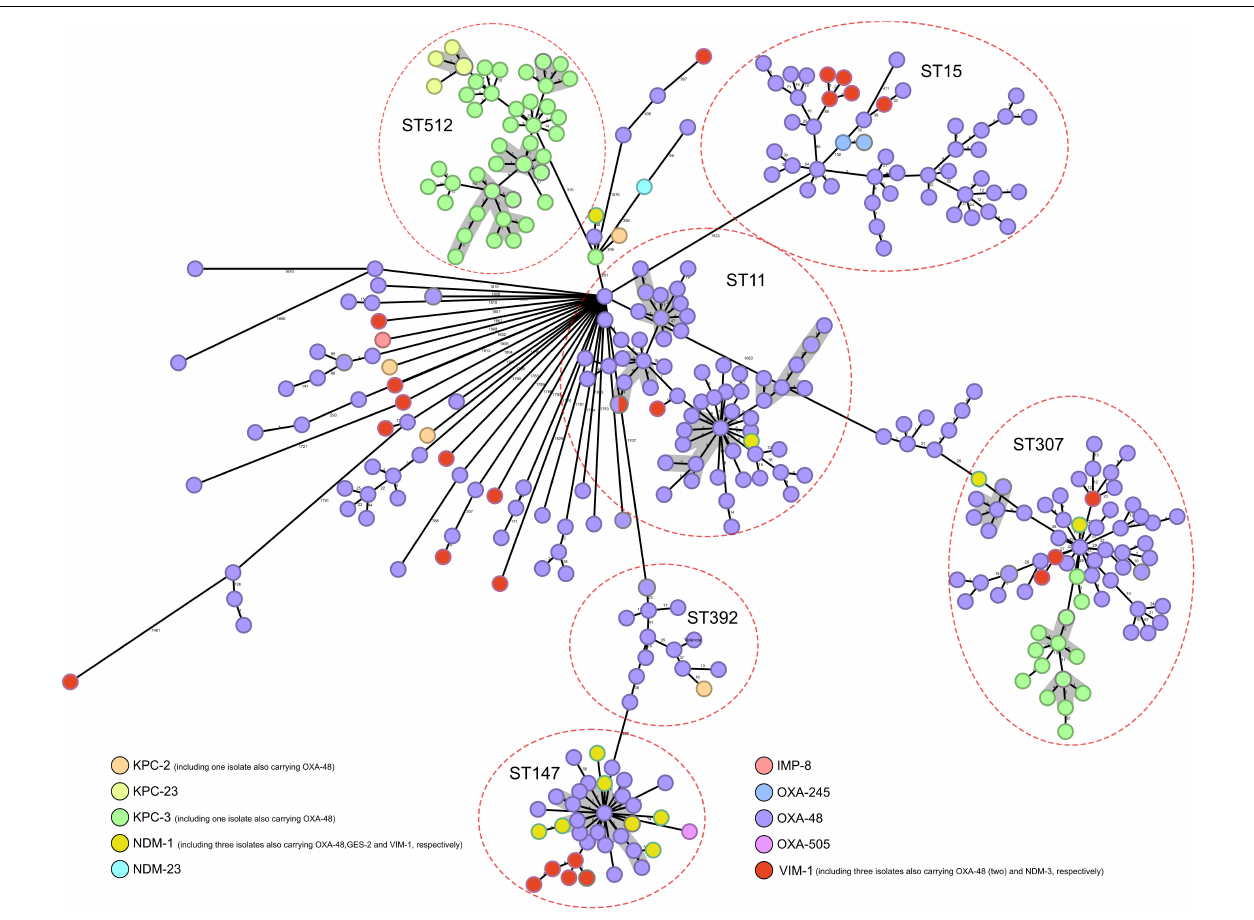
FIGURE 3 | Population structure of carbapenemase-producing Klebsiella pneumoniae : minimum-spanning tree. Distances shown are based on cgMLST of 2,358 genes using the parameter “pairwise ignoring missing values.” Colors in each circle indicate carbapenemase type. Red ovals represent clusters. Circles can correspond to more than one isolate, indicating that they are identical. Gray shadows represent clusters of strains, applying a threshold of both 5 SNPs and 10